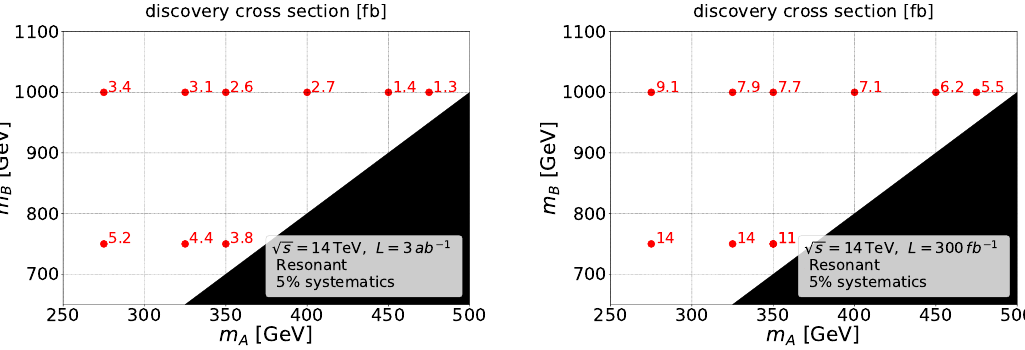
Figure 11 . Cross sections (in fb) required for a discovery at the HL-LHC in the m A (cid:0) m (cid:31) plane for the resonant model, with 3 ab (cid:0) 1 (left panel) and 300 fb (cid:0) 1 (right panel). We have (cid:12)xed m (cid:31) = 25 GeV, but as explained in the text this parameter is not relevant for the sensitivity provided that 2 m (cid:31) < m A